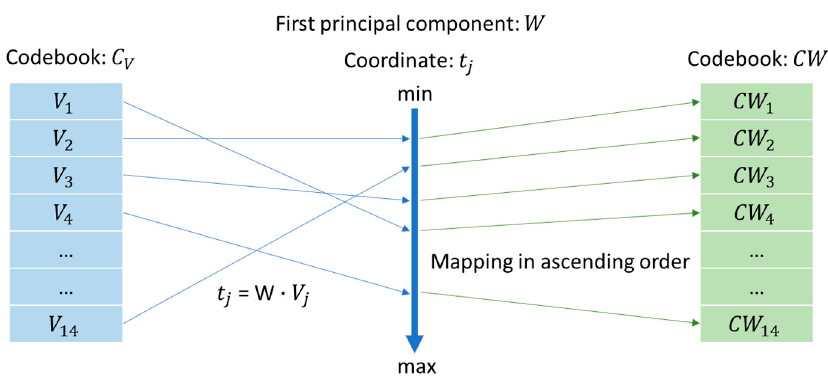
Figure 5. Illustration of the codebook sorting.